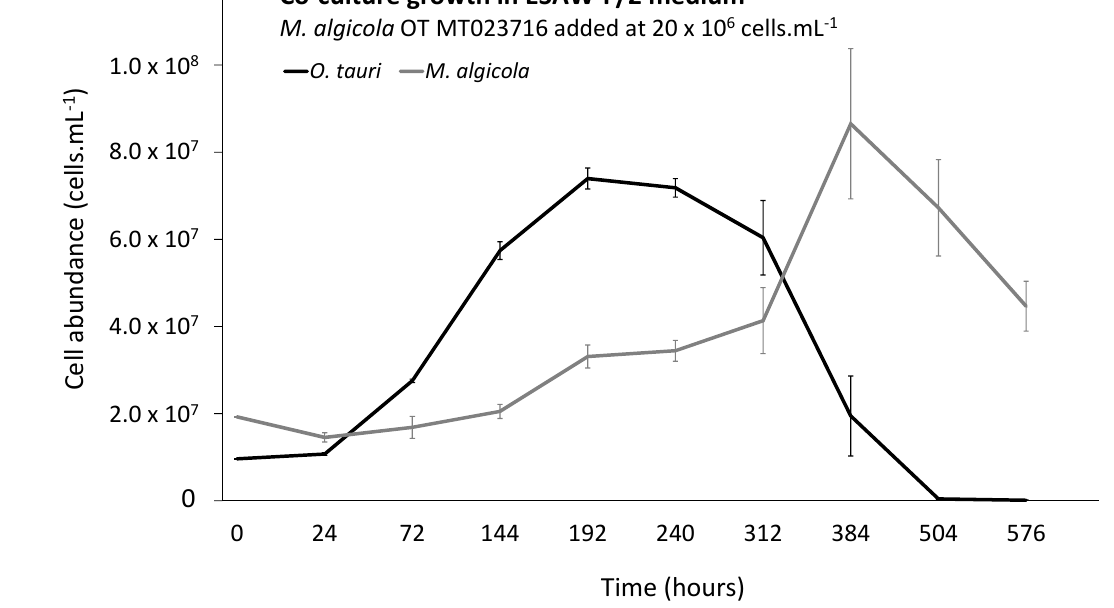
Figure 3. M. algicola OT MT023716 growth under different experimental conditions. ( A ) M. algicola OT MT023716 monoculture growth in ESAW-F/2 and marine broth media; ( B ) O. tauri RCC4221 and M. algicola OT MT023716 coculture growth in ESAW minus vitamin B 12 , showing that a sufficient number of O. tauri cells in stationary phase induces M. algicola OT MT023716 growth.